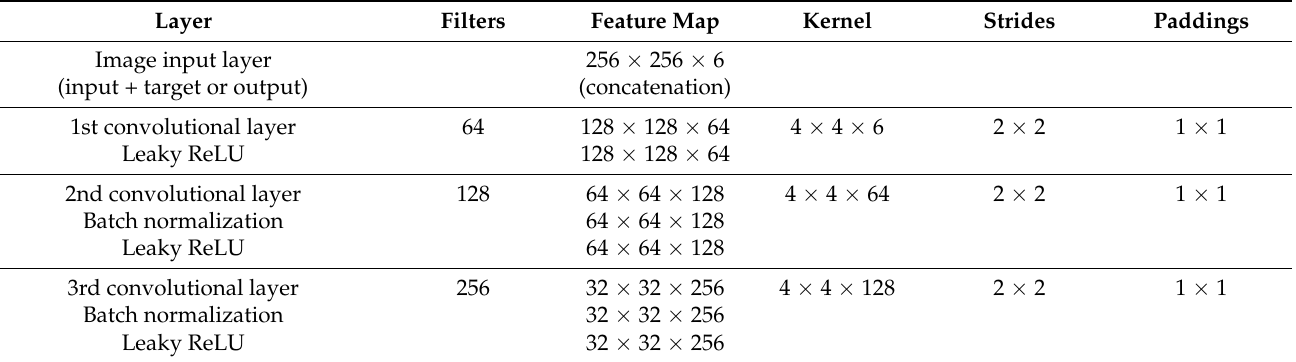
Table 3. The architecture of the proposed discriminator